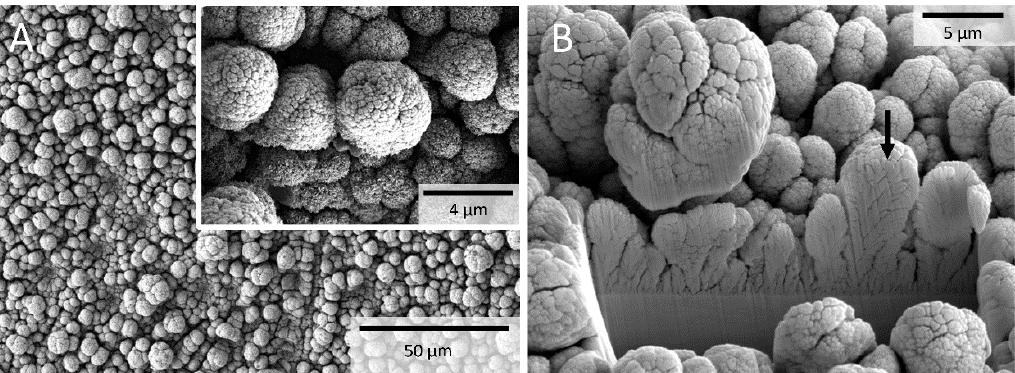
Figure 2. Scanning electron microscopy of the full-surface metal coating with porous platinum after alloying with copper and alternating dealloying. The surface shows different forms of growth (A). In deeper layers, finger-like structures can be seen, which become more cauliflower-like towards the top (insert). A cross-section with the focused ion beam shows channel structures up to the platinum foil (B). The height of the average structures (arrow in B) is around 10 µm.